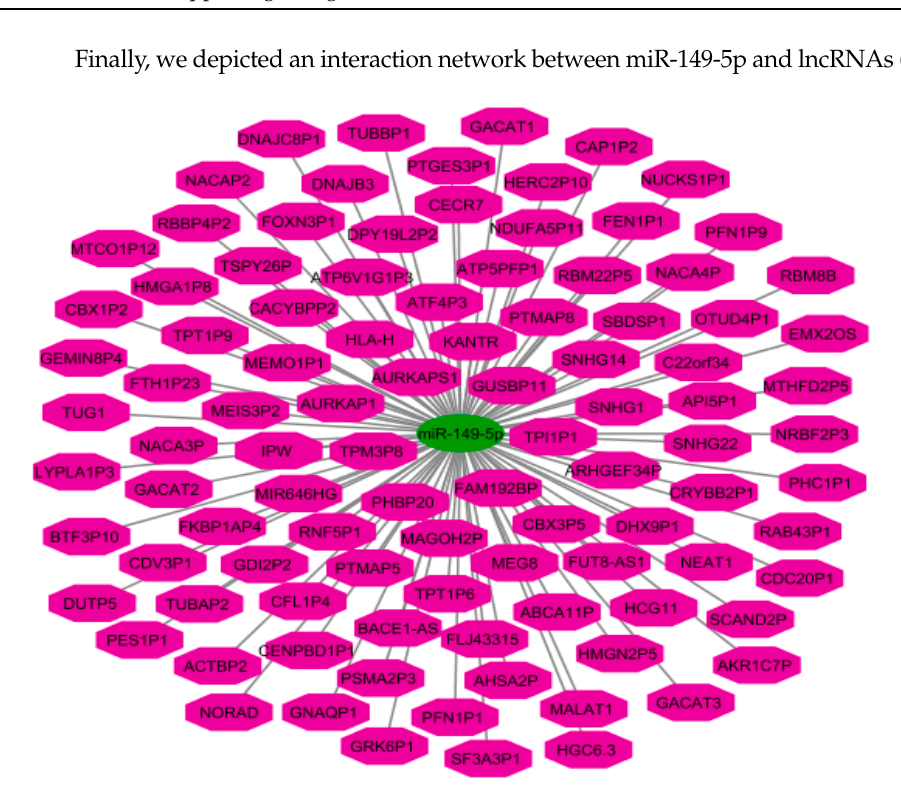
Figure 3. An interaction network between miR-149-5p and long non-coding RNAs (lncRNAs). The pink octagon and green ellipse indicate lncRNAs and miR-149-5p, respectively. The graph visualization was constructed by Cytoscape version 3.6.1.